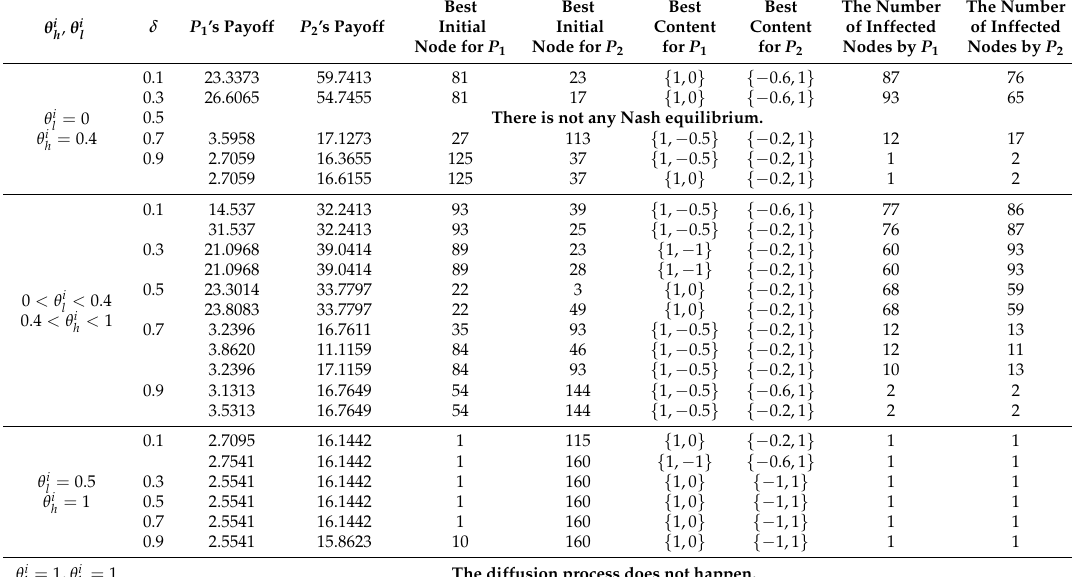
Table 2. Nash equilibrium for different parameters for the Abrar data set.